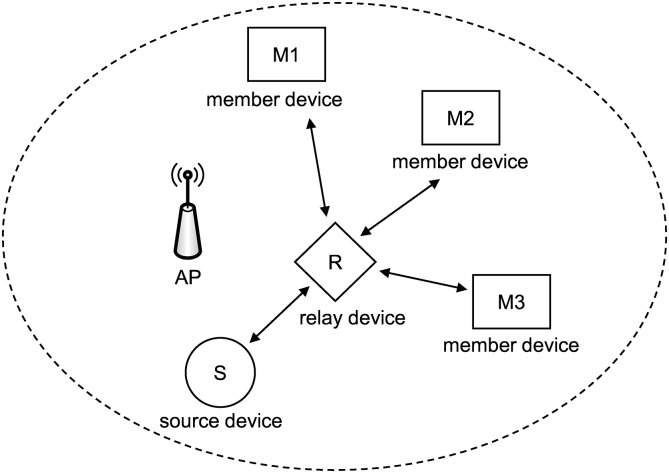
Streaming mechanism.